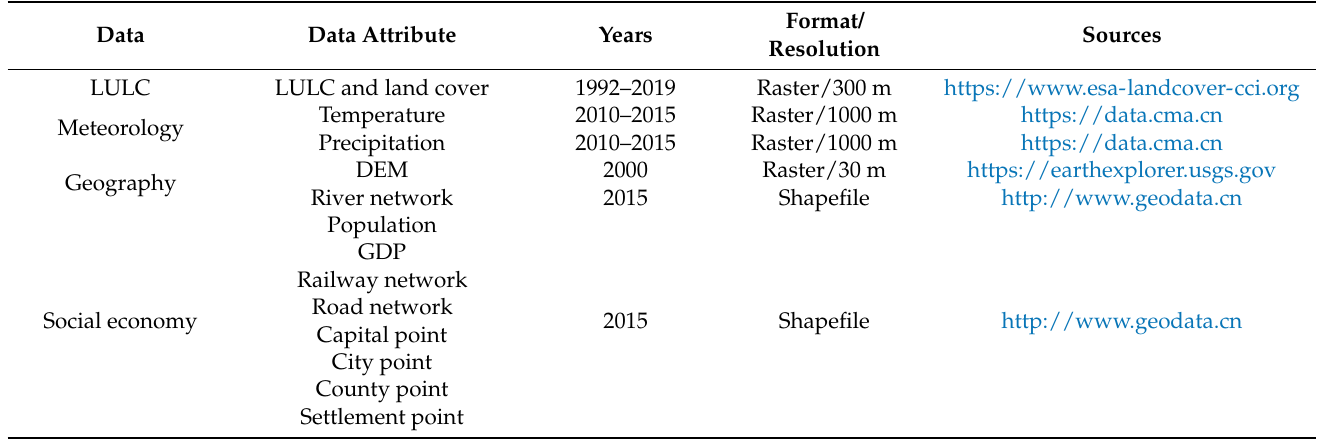
Figure 1. The location and general geographical information of Hainan Island. Table 1. Details of LULC and driving factors